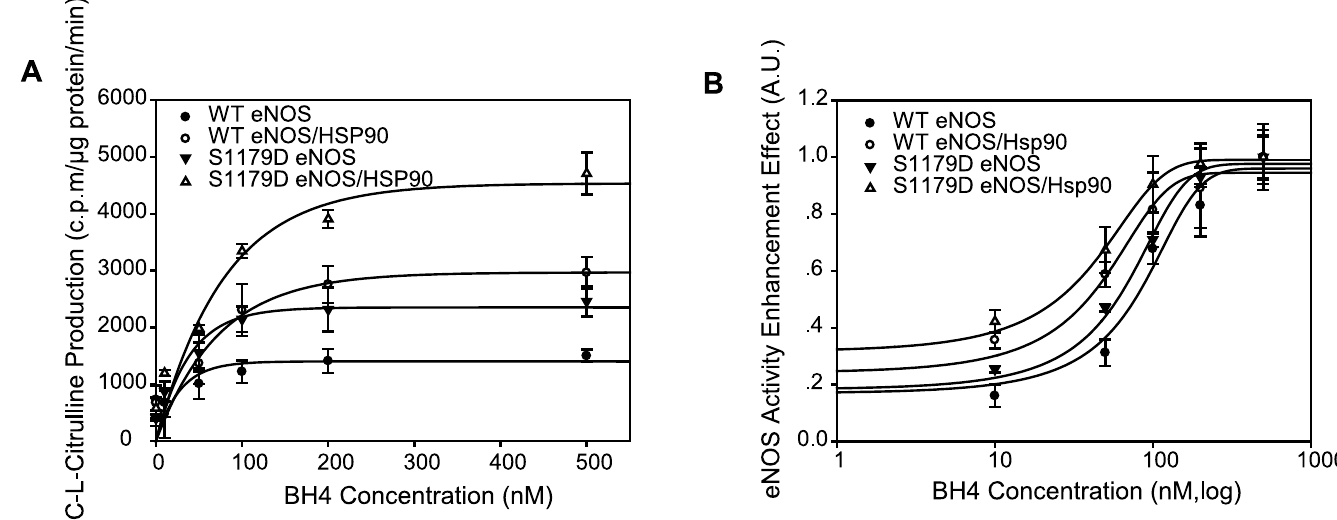
Fig 6. Hsp90 did not enhance either WT eNOS or S1179D eNOS affinity to BH4. (A) Hsp90 augmented both WT eNOS and S1179DeNOS activity capacity in the presenceof BH4. The effect of Hsp 90 on enzymatic activity of WT eNOS and S1179DeNOS was assayed by monitoringthe conversion rate of L-14C-arginine to L-14C-citrullinein the presenceof indicatedconcentration of BH4 (n = 5). (B) BH4-eNOS activity dynamic assay showedthat Hsp90 did not change either WTeNOS or mutant S1179Dsensitivity to BH4 (EC50, P > 0.05;n = 5). In contrast, mutation of S1179Dsignificantly enhanced eNOS affinity to BH4 comparedto their WT eNOS control in the absenceor presenceof Hsp90 (EC50, P < 0.05;n= 5).